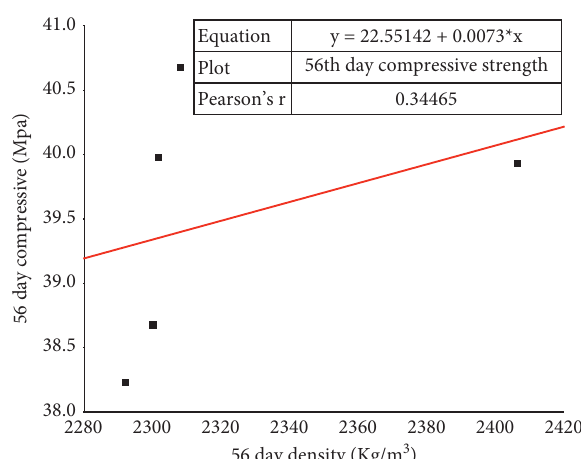
Figure 6: Compressive strength and density regression at 56 days.